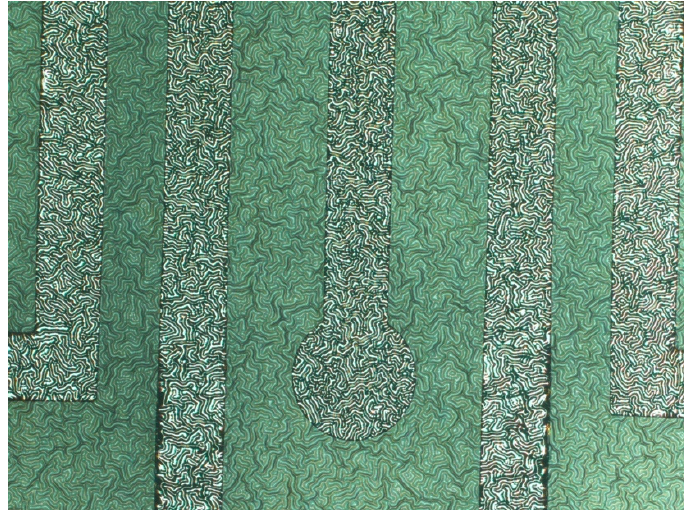
Figure A1. Cr/Au/Cr metal layer deposited on PDMS. Conductive tracks were designed to be 100 μm Figure A1. Cr / Au / Cr metal layer deposited on PDMS. Conductive tracks were designed to be 100 µ m in width and the circular electrode to be 200 μm in diameter. in width and the circular electrode to be 200 µ m in